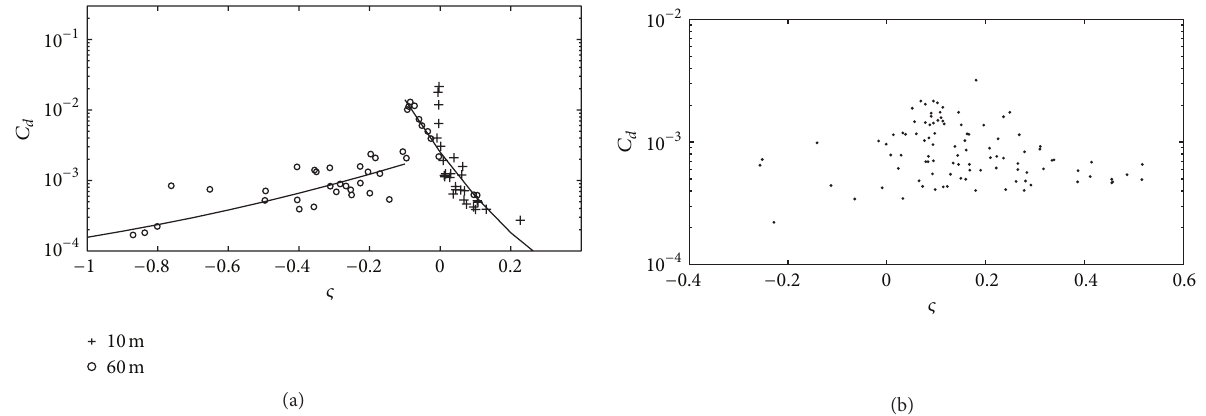
Figure 7: Variations of drag coefficient with atmospheric stability in onshore direction during strong typhoons: (a) typhoon Nuri at 10m and 60m height and (b) typhoon Hagupit at 60 m height.